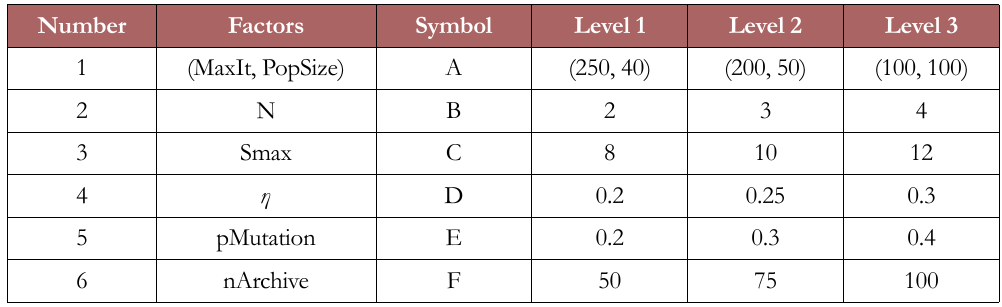
Table 2. Factors and their